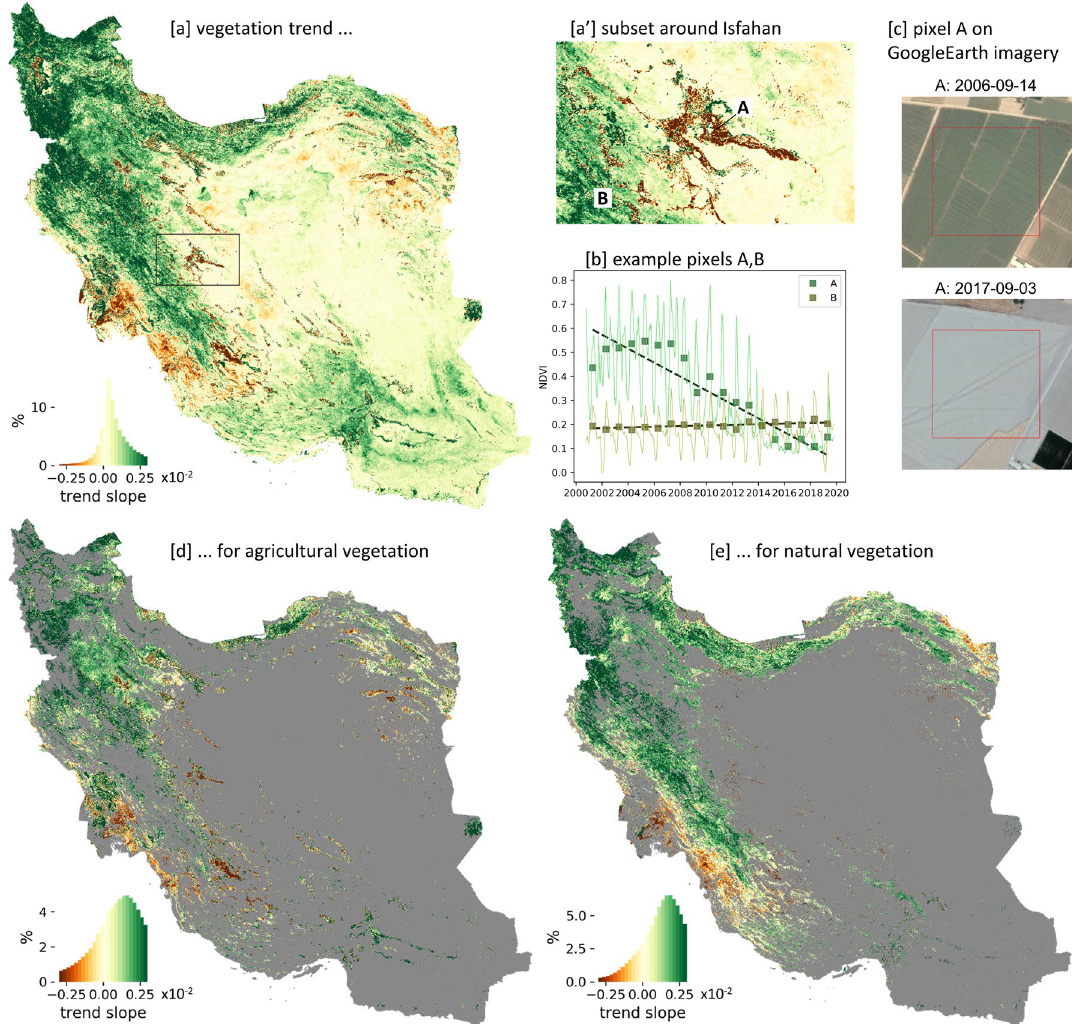
Figure 5. Vegetation growth trends of Iran. ( a ): Vegetation growth trend (trend slope of annual vegetation growth NDVI MEAN ∗ time series between 2001 and 2019) for Iran with subset around Isfahan ( a’ ). ( b ): At two example pixels A and B the pre-processed MODIS NDVI time series (line plot), the annual vegetation growth NDVI MEAN ∗ (rectangles), and the trend (dashed line) are given. ( c ): The footprint of the MODIS example pixel A of 250 m × 250 m is overlaid in red on historical high resolution Google Earth imagery, showing the decrease in agricultural usage. ( d ): Vegetation growth trends for agricultural areas. ( e ): Vegetation growth trends for naturally vegetated areas. Maps were created using Python 3.9 (https://www.python.org/).